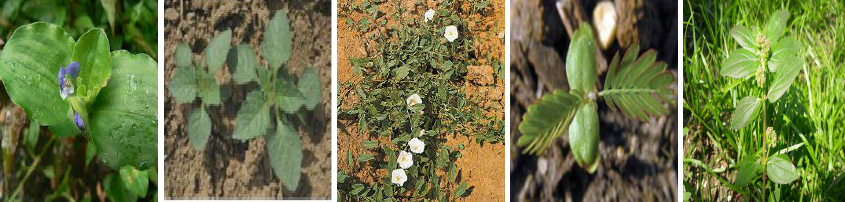
Figure 6. From left to right: Benghal dayflower, black nightshade, hedge bindweed, Indian jointvetch, snakeweed (Source: [41]).